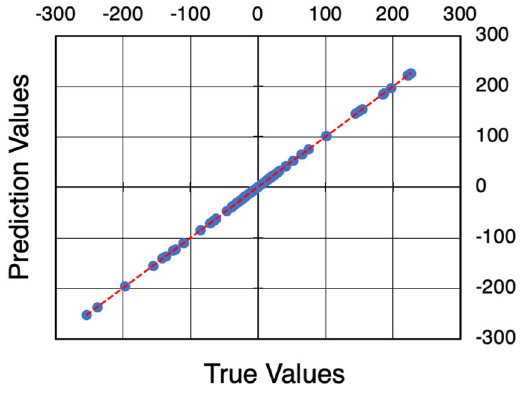
Fig. 4 The deep learning predictions with respect to correspond- ing the reference values. A scatter plot of INDEEDopt predictions versus the ReaxFF calculations (i.e., true values). The blue dots are the data points and the red line is the linear trend line. The data points and the percent difference between the predictions and the true values can be seen in Supplementary Table